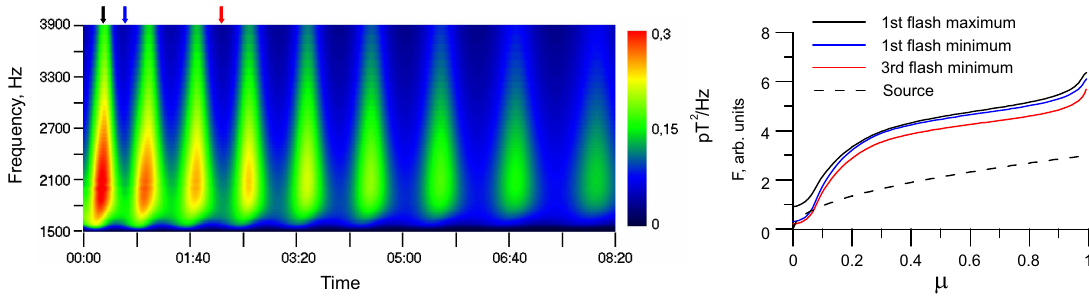
Fig. 1. Relaxation oscillations regime in the model with losses due to precipitation. Spectrogram of the wave intensity is on the left panel and snapshots of pitch angle distribution of energetic electrons in the duct (solid lines) and distribution in the source defined by Eq. (11) (dashed line) are on the right panel, time marks for snapshots are given in the corresponding color at the top of the spectrogram. System parameters are L =4.4, n cL = 55 cm − 3 , W 0 = 45 keV, ln R = 2 ω/ω 0 , J 0 = 10 6 cm − 2 s − 1 .